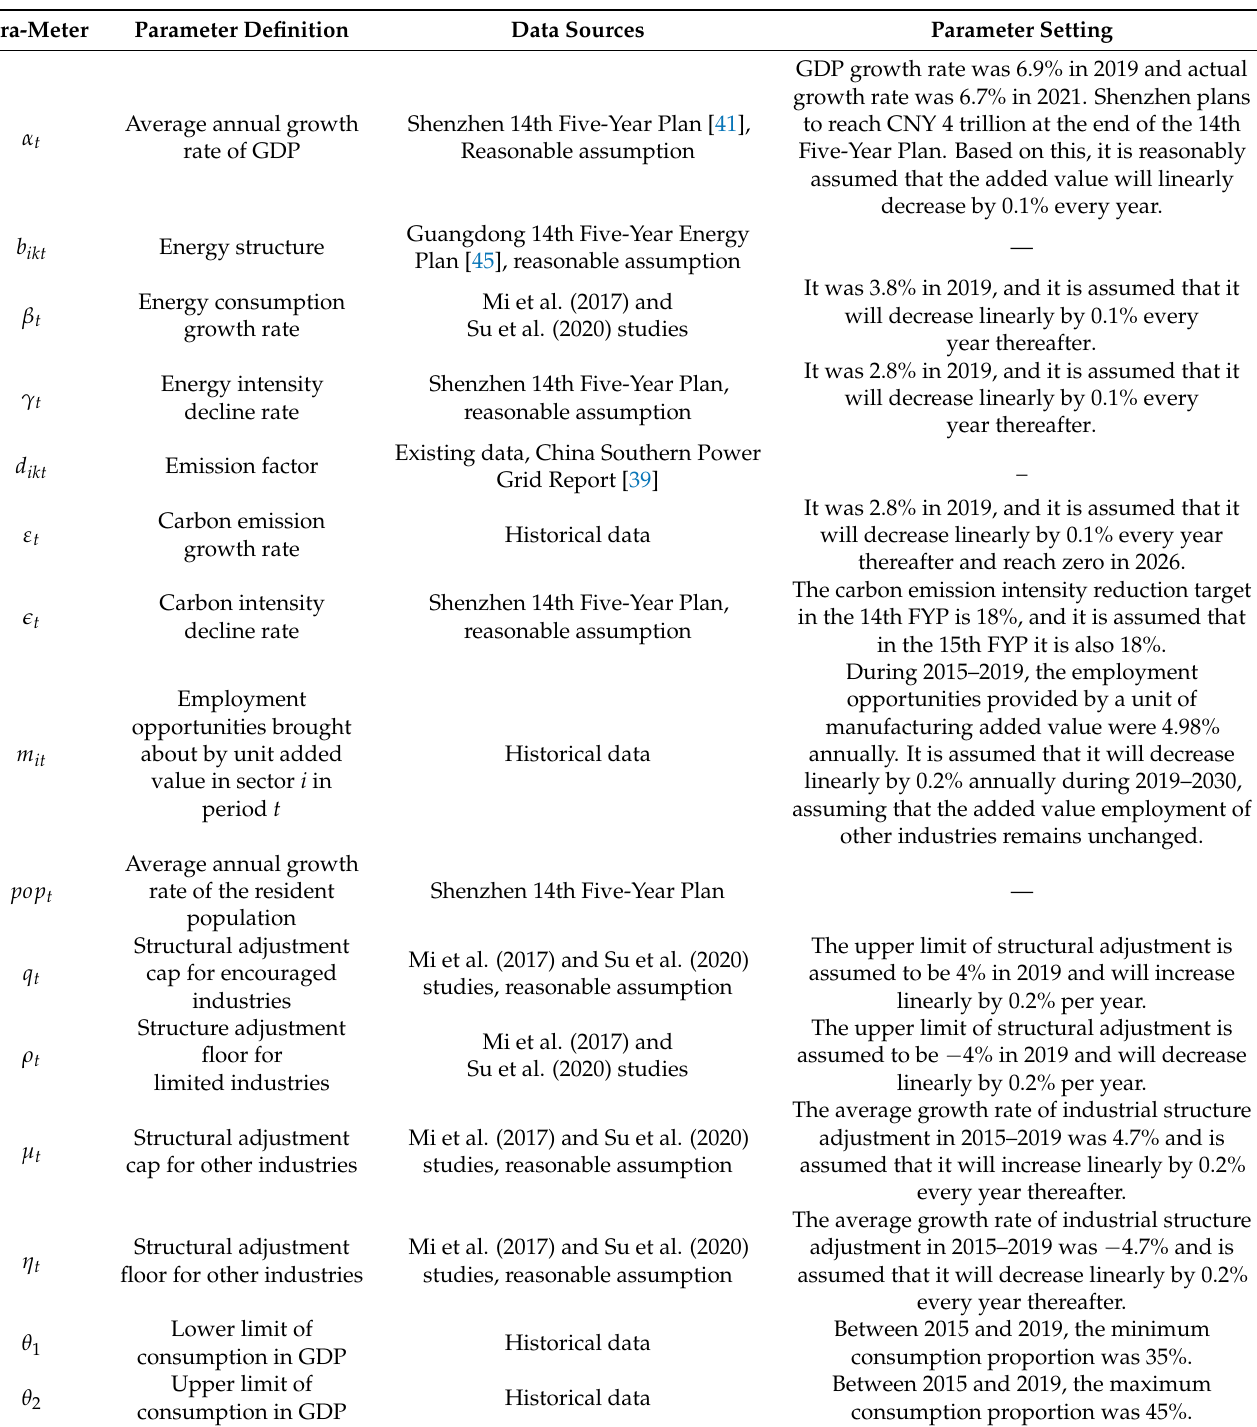
Table A1. The settings of exogenous parameters in the